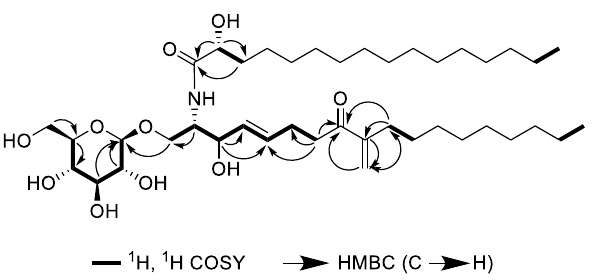
Figure 2. The key COSY (bold) and HMBC (arrows) correlations of compound